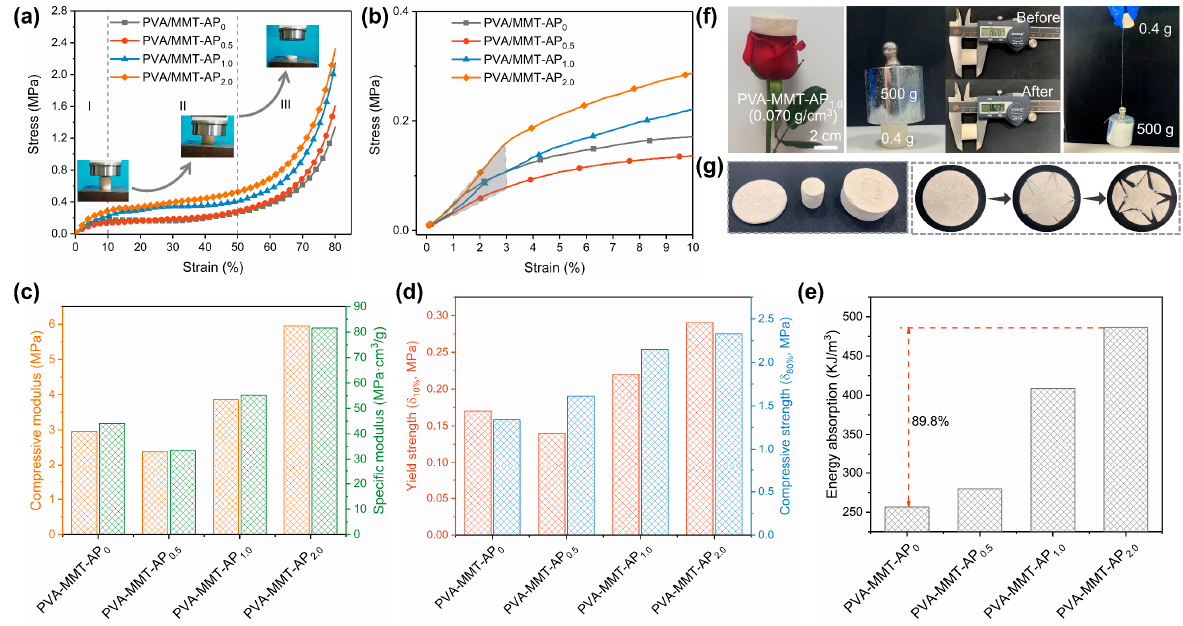
Figure 3. ( a ) Compressive stress-strain ( δ - ε ) curves and ( b ) the enlarged δ - ε curves of the PVA-MMT-AP x aerogel composites (insets: photos of the PVA-MMT-AP x under the compression test). The linear gray region (1% < ε < 3%) is used to determine the compressive modulus. ( c ) Compressive modulus and specific modulus. ( d ) Yield strength ( δ 10% ) and compressive strength ( δ 80% ). ( e ) Absorption energy (at 80% strain) of the PVA-MMT-AP x . ( f ) The PVA-MMT-AP x standing on the rose; pressed or pulled by a weight of 500 g. ( g ) The clay aerogel composites with customizable shapes and their machinability.